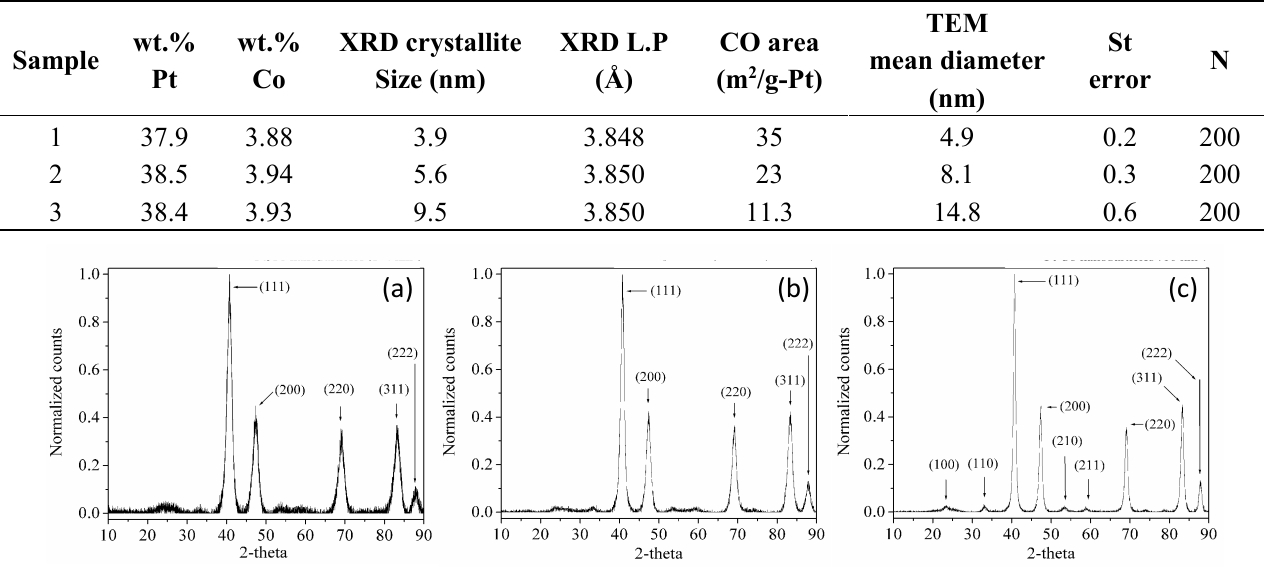
Table 1. Characterization of Pt 3 Co/Ketjen EC 300J catalysts tested.